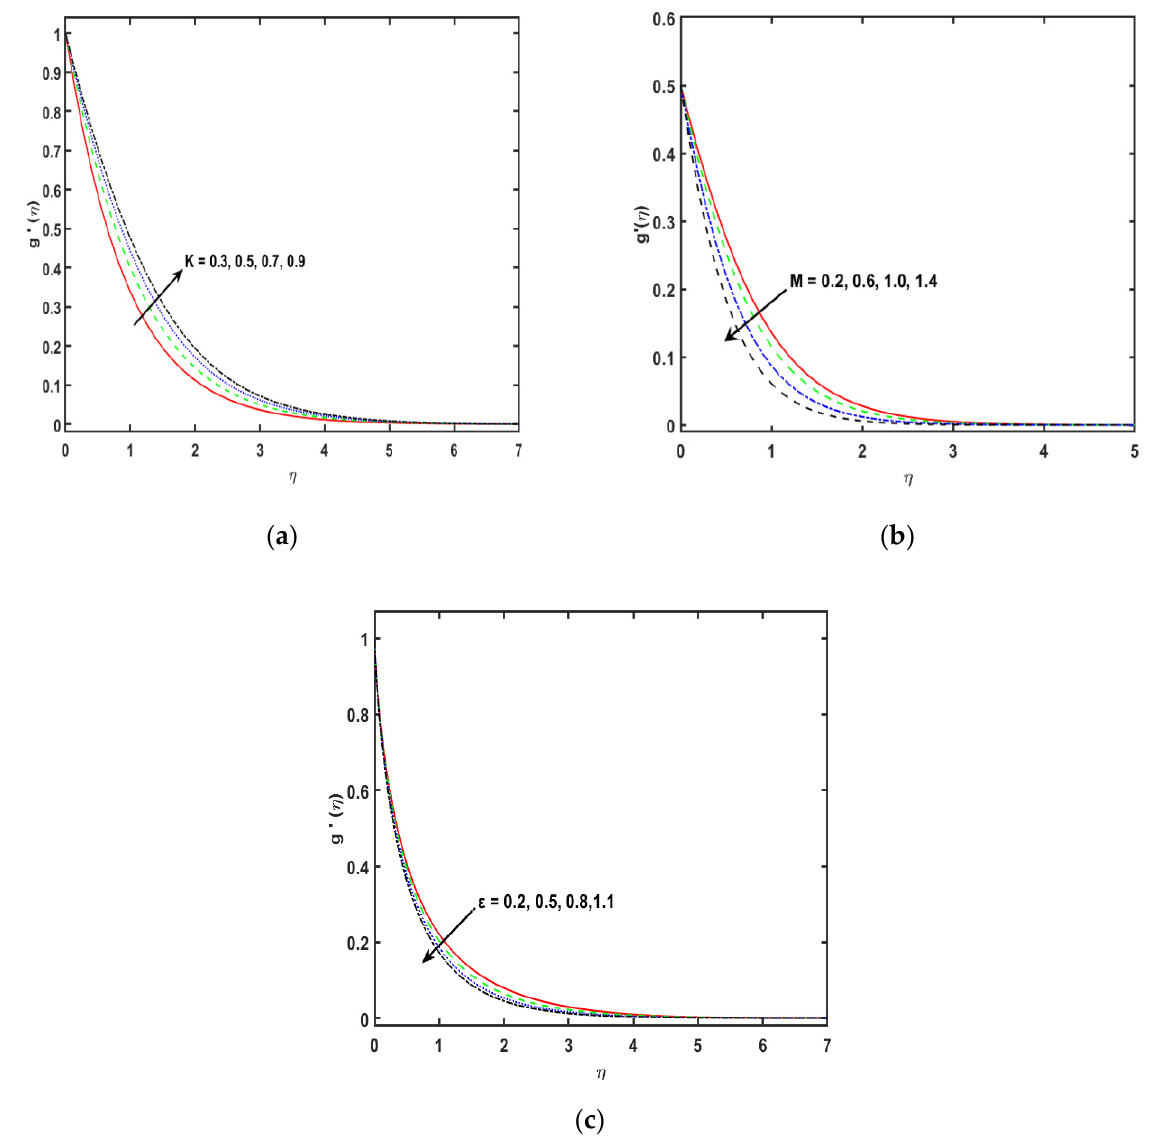
Figure 3. ( a – c ): Variation in 𝐾, 𝑀 and 𝜀 against 𝑓′(𝜂) , respectively.